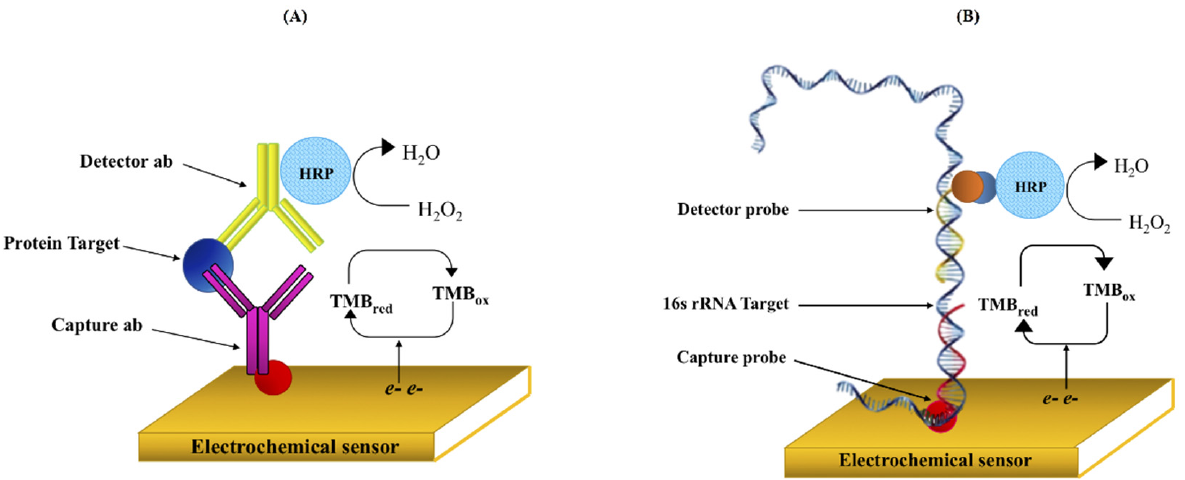
Figure 2. Urine-based diagnostics for the electrochemical biosensor detection of nucleic acids and proteins: ( A ) scheme for pathogen identification based on sandwich hybridization between bacterial 16S rRNA and capture and detector oligonucleotide probes; ( B ) sandwich detection using capture and detection antibodies. The schematic diagrams of the immunoassay based on host urinary proteins were adapted from Mohan, R.; Mach, K.E.; Bercovici, M.; Pan, Y.; Dhulipala, L.; Wong, P.K.; Liao, J.C. Clinical Validation of Integrated Nucleic Acid and Protein Detection on an Electrochemical Biosensor Array for Urinary Tract Infection Diagnosis. PLoS One 2011, Reference [41].